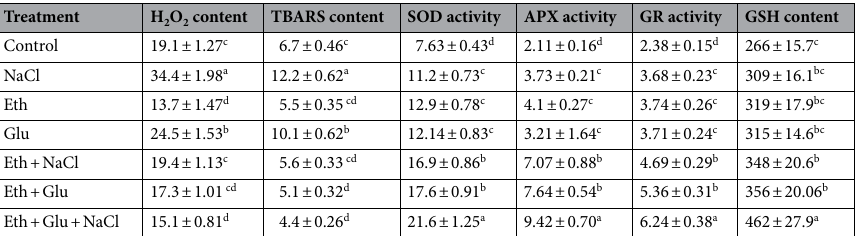
Table 3. H 2 O 2 content (nmol g −1 FW), content of thiobarbituric acid reactive substances (TBARS, nmol g −1